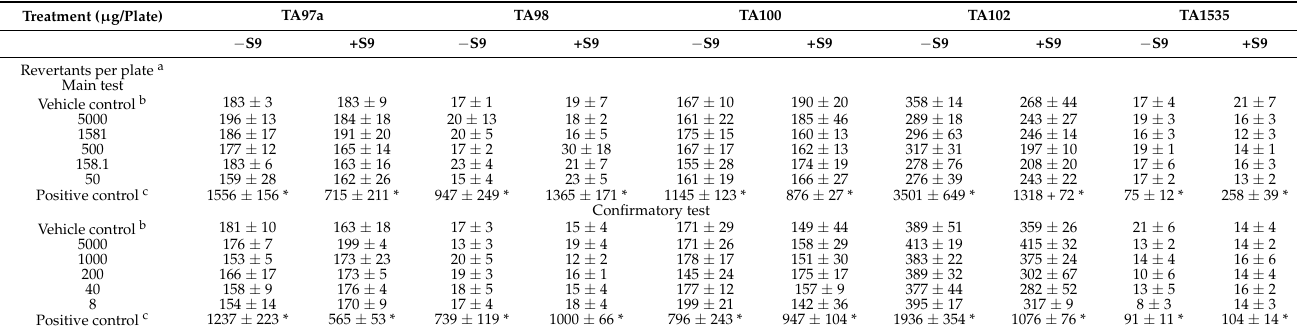
Table 3. Bacterial reverse mutation assay of emu oil.